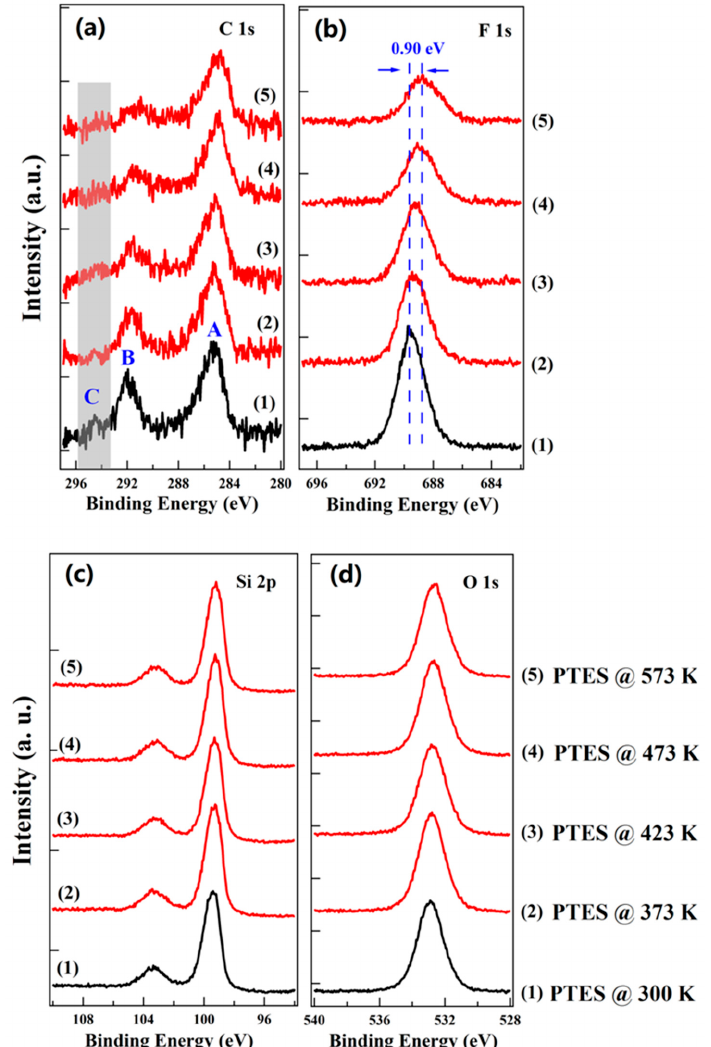
Figure 3. XPS spectra of ( a ) C 1s, ( b ) F 1s, ( c ) Si 2p, and ( d ) O 1s for PTES as a function of vacuum annealing temperature, respectively.